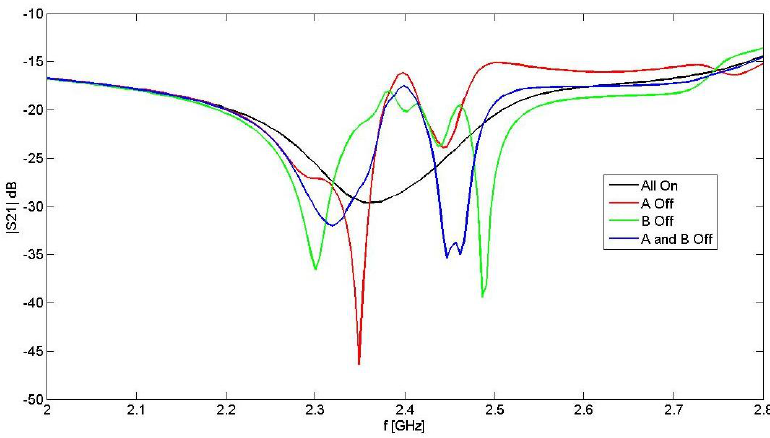
Figure 5. Isolation between port 1 and 2 for some antenna configurations.